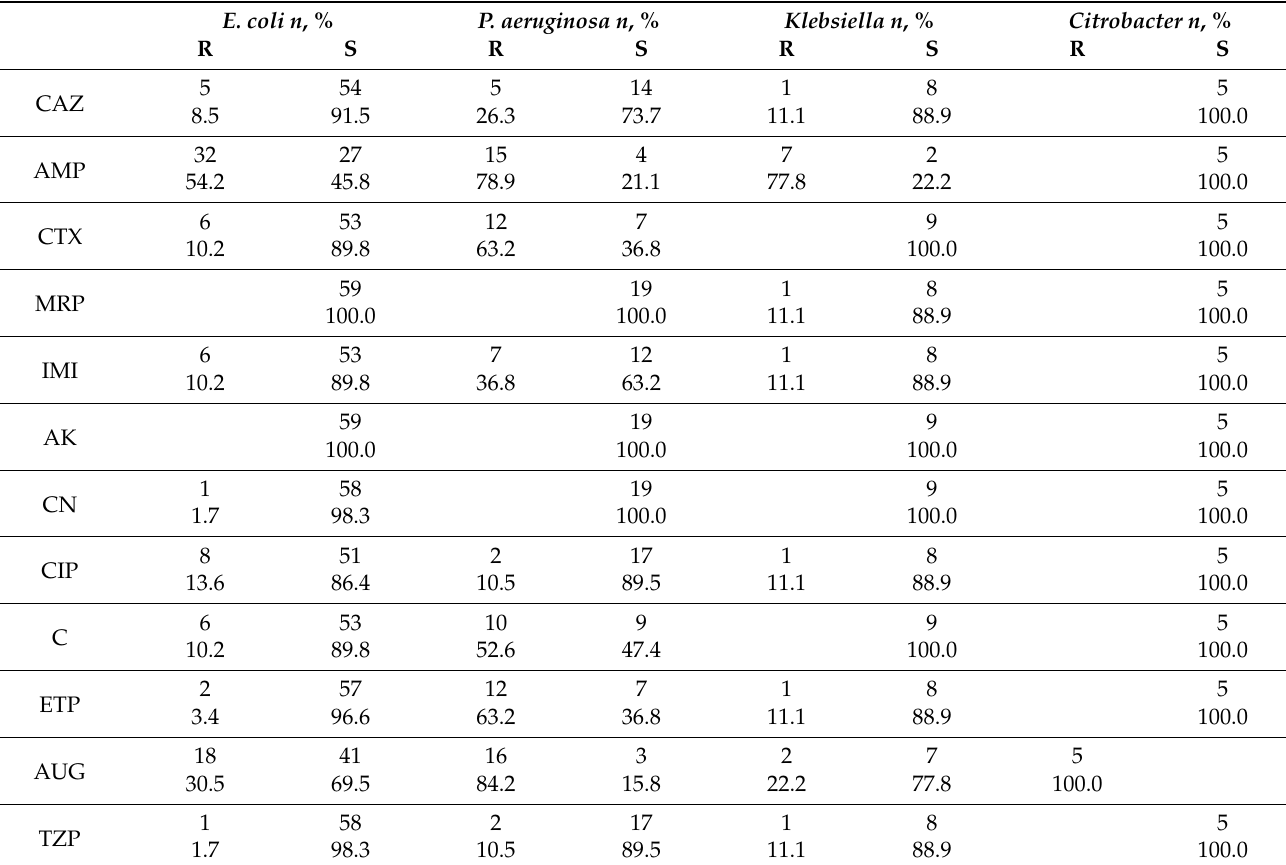
Table 3. Antimicrobial resistance and susceptibility of isolated